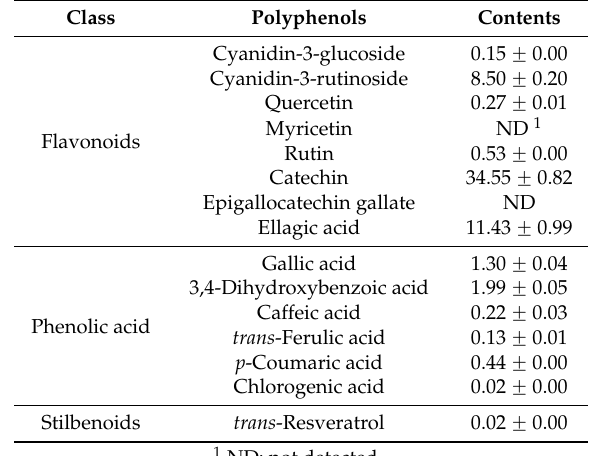
Table 1. Contents of polyphenols in RCSF1 by LC/MS/MS (mg/g).